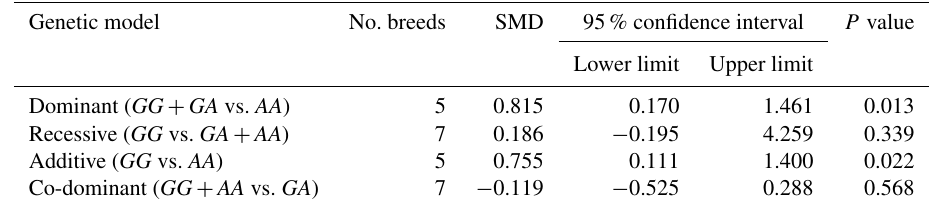
Table 3. The outcomes of meta-analysis of the association between the c.963A > G polymorphism and the litter size under different genetic models.